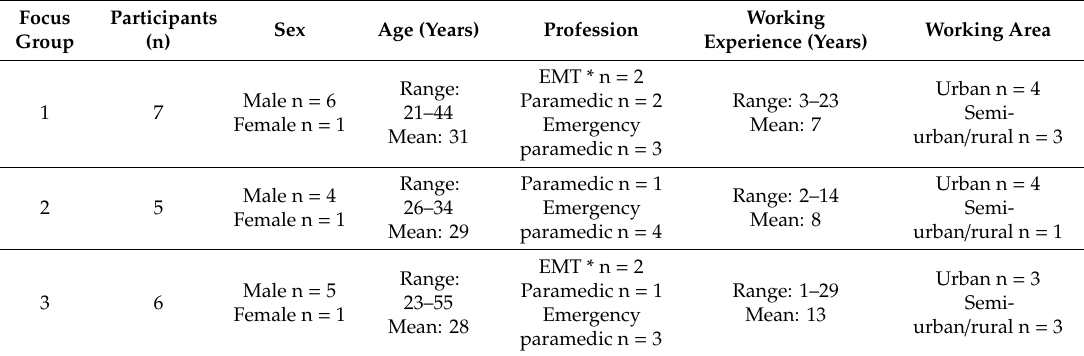
Table 1. Description of focus group